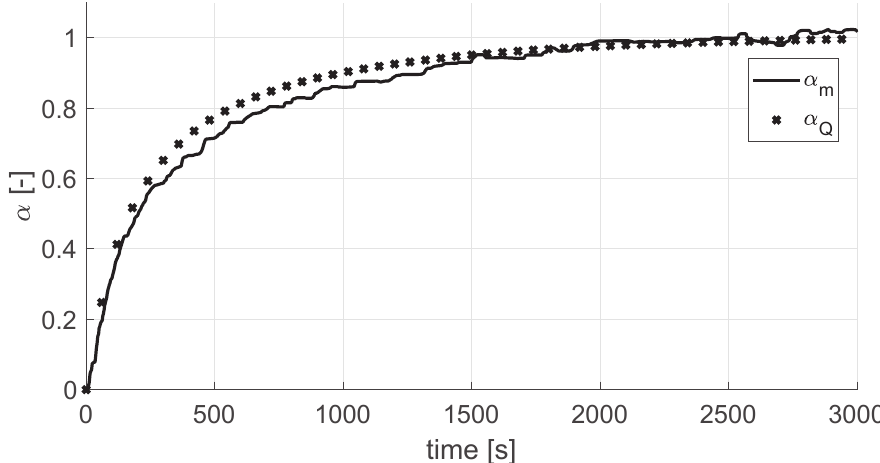
Figure 6. Validation of pseudo-steady state conditions for T hyd = 40 ◦ C and P wv , hyd = 12